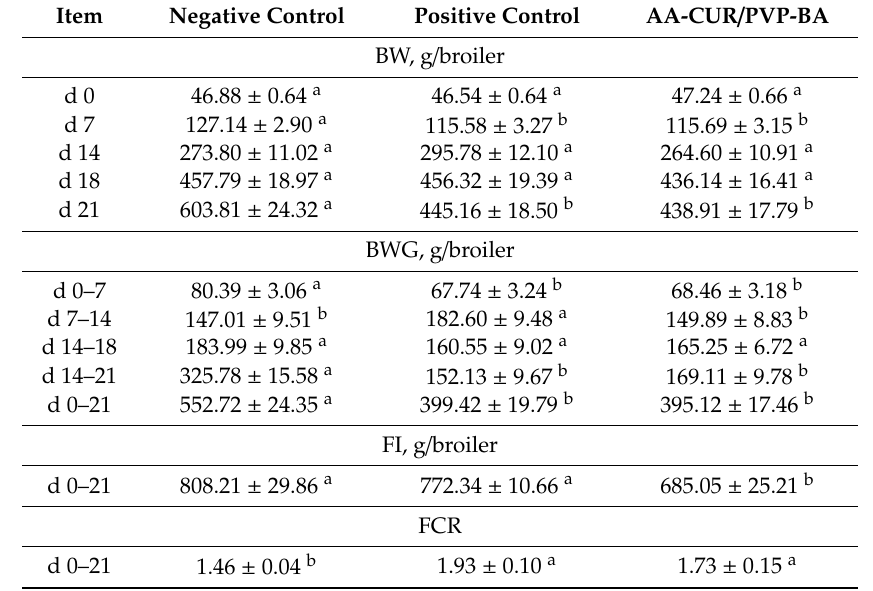
Table 5. Evaluation of body weight (BW), body weight gain (BWG), feed intake (FI) and feed conversion ratio (FCR) in broiler chickens consuming a diet supplemented with or without a 0.1% mixture containing ascorbic acid (AA) and a solid dispersion of curcumin with polyvinylpyrrolidone (CUR / PVP, ratio 1:9) and boric acid (BA) (AA-CUR / PVP-BA) on a Necrotic enteritis challenge model 1 (Experiment 3).